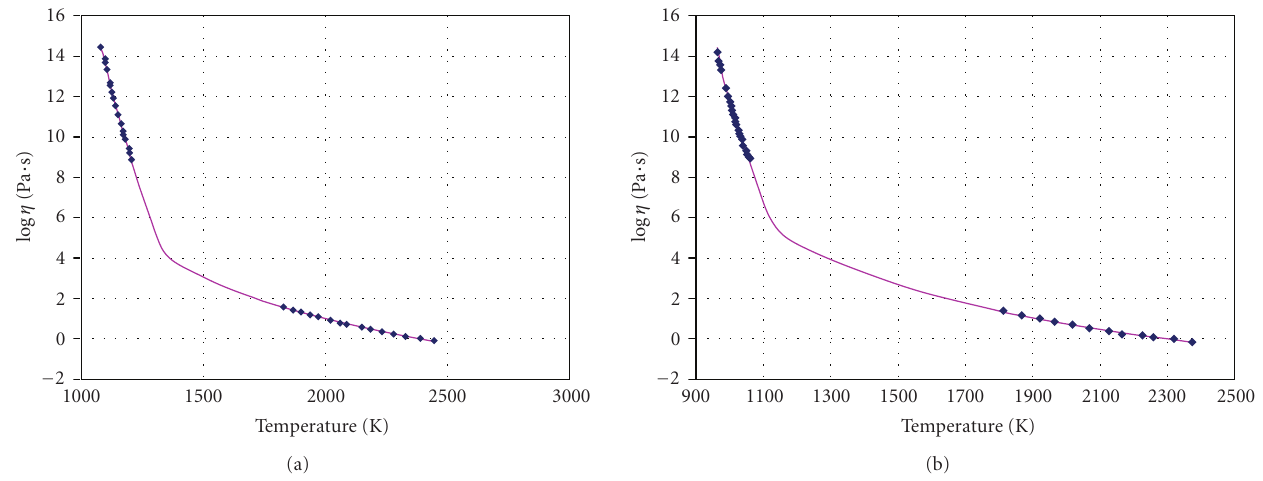
Figure 7: (a) Viscosity-temperature data for anorthite and (b) for diopside, where calculated curves were obtained using (12).